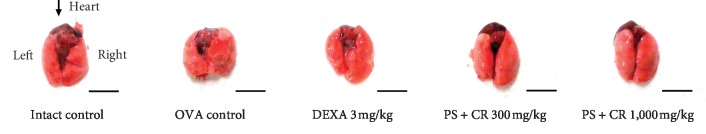
Representative lung gross images, taken from intact or OVA-induced asthmatic mice. Marked enlargement of lung-edematous changes was detected in OVA control mice as compared with intact control mice. However, these OVA-induced pulmonary edematous changes were dose-dependently inhibited by oral treatment with PS + CR 300 and 1,000 mg/kg, as being comparable to the effects of DEXA 3 mg/kg oral administration. PS = Pelargonium sidoides; CR = Coptis Rhizoma; PS + CR = PS and CR 2 : 1 mixed formula; OVA = ovalbumin; DEXA = dexamethasone. Scale bars = 7 mm.